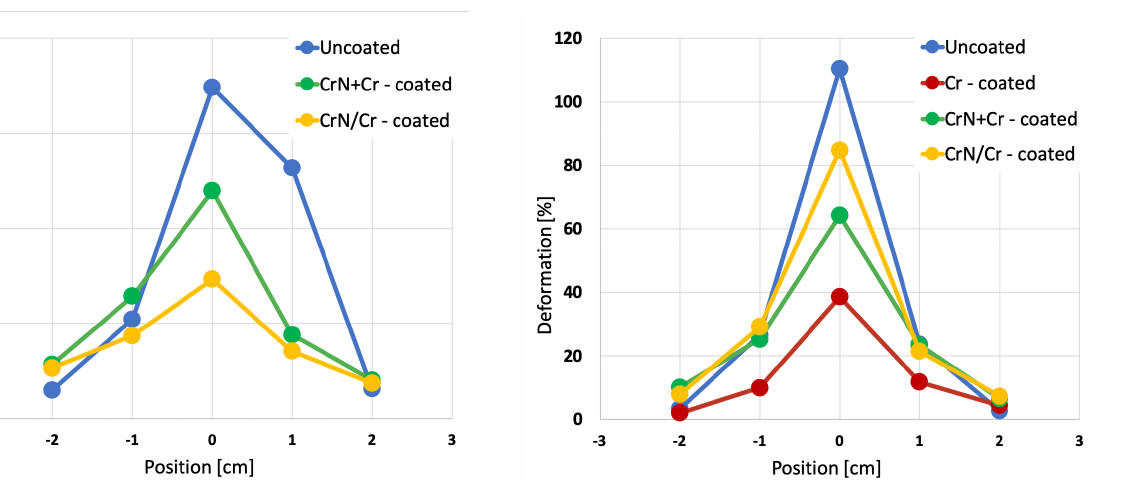
higher creep rate.